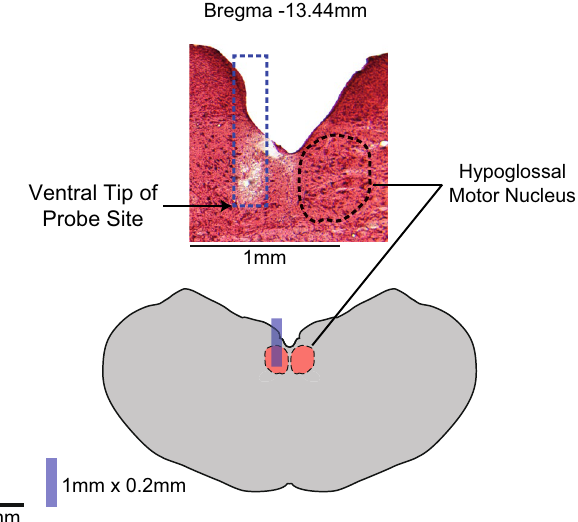
Figure 1. Example of site of microdialysis at the hypoglossal motor nucleus (HMN). The ventral tip of the microdialysis probe identified from the tissue disruption left by the probe is indicated by the arrow. The reconstruction of the probe position and the contralateral HMN outlined by a dotted line are shown (top figure). A schematic representation of the coronal section of medulla 13.44 mm posterior to bregma is also shown with the reconstructed probe position drawn to scale (bottom